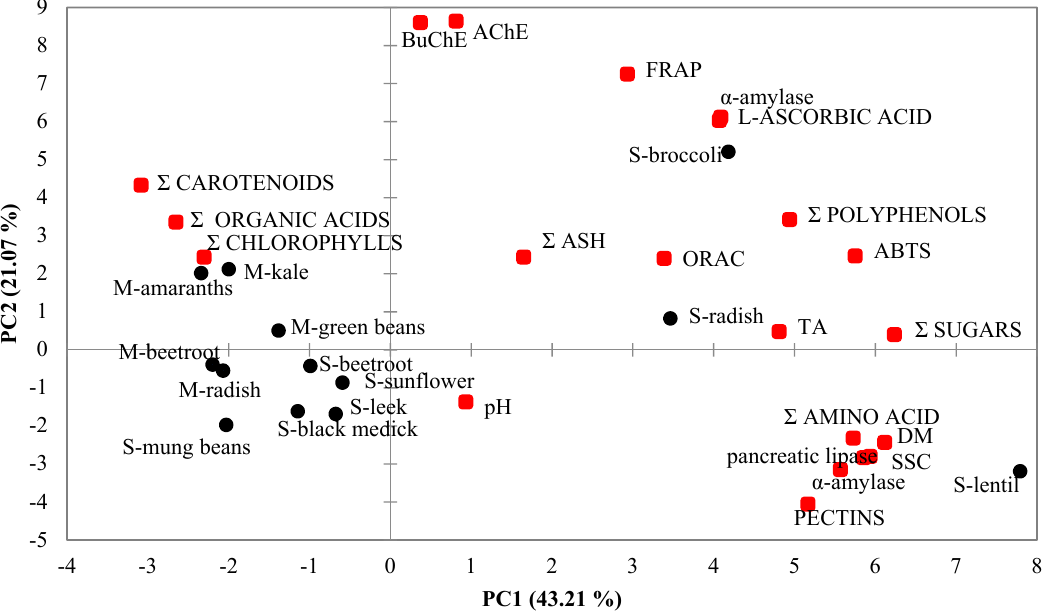
Figure 1. Factor plot principal component 1 (PC1) versus PC2 present the association data for sprouts and microgreens. DM—dry matter; SSC—soluble solid; TA—titratable acidity; S—sprouts; M— microgreens.